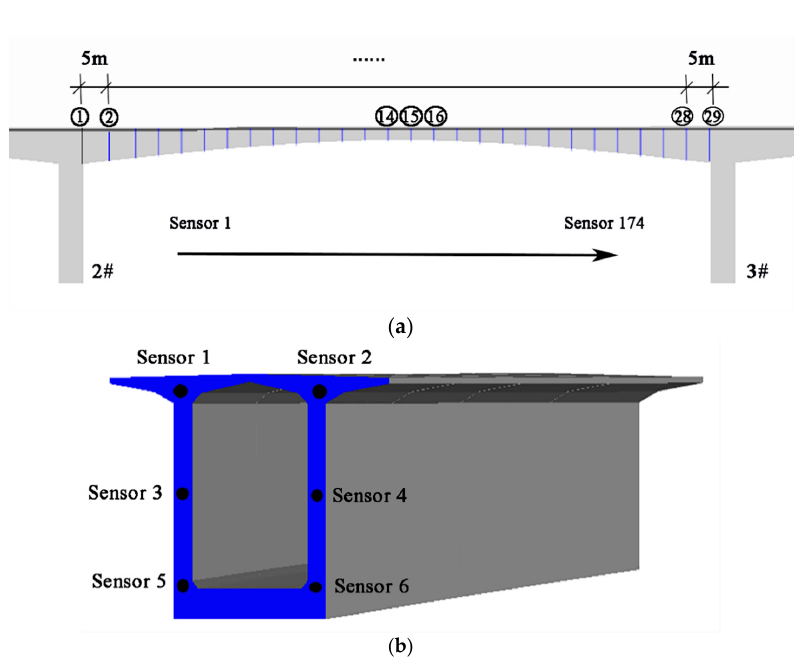
Figure 15. Spatial distribution of the sensors in the span between the 2# and 3# piers: ( a ) the arrangement of the monitoring section marked in blue along the bridge; ( b ) the arrangement of the sensors in the monitoring section.